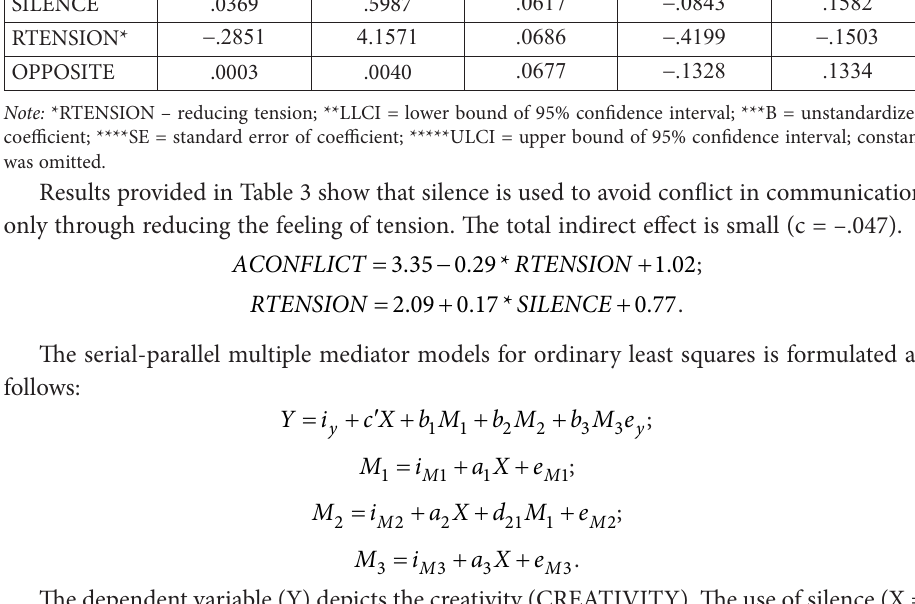
Table 3. Coefficient estimates for ordinary least squares model (source: created by authors) Construct B***